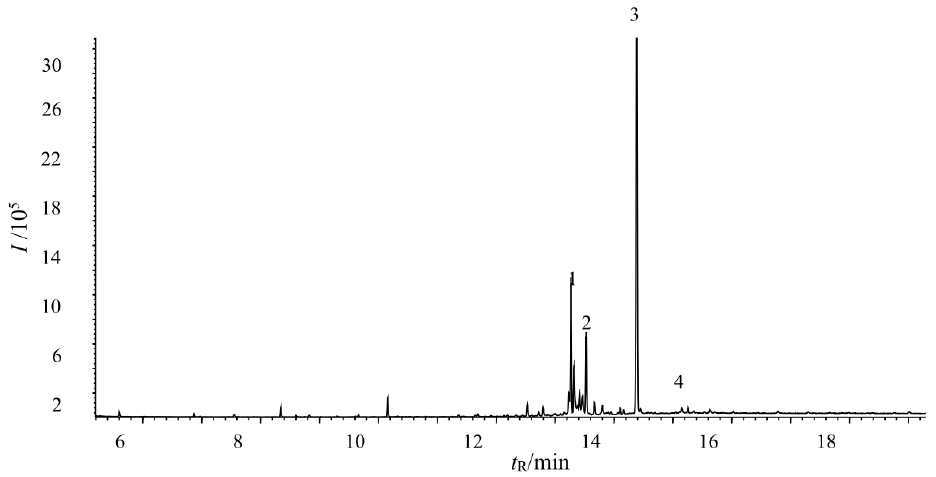
Figure 4. Total ion chromatogram of the tobacco cembranoids extract. Peaks 1, 2, 3, and 4 represent tobacco cembranoids.